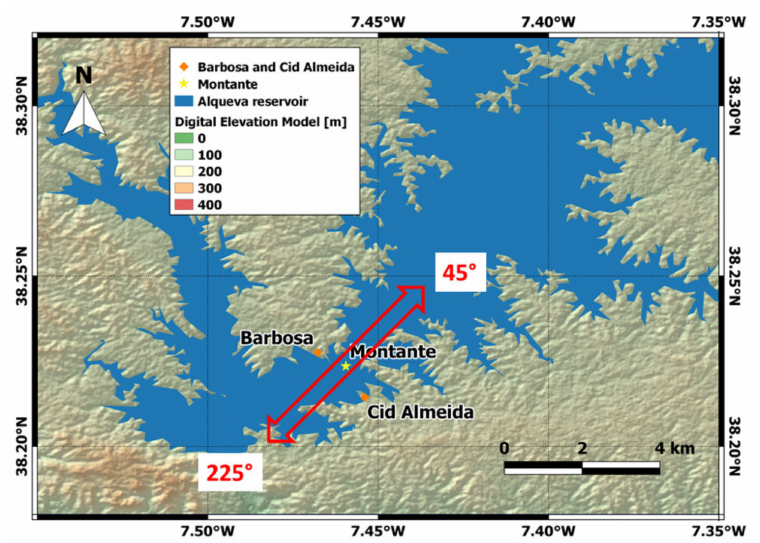
Figure 2. Location of the meteorological stations and the 225 ◦ –45 ◦ plane (in the SW–NE axis) used in this study to detect the lake and land breeze occurrences. Source: